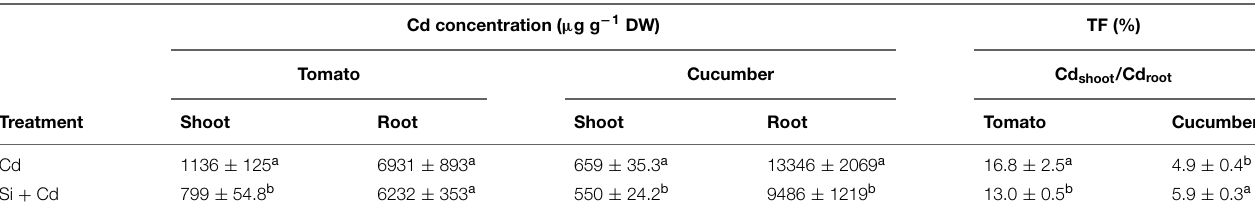
TABLE 2 | Cadmium concentrations and translocation factors ( TF ) in tomato and cucumber grown hydroponically without or with added